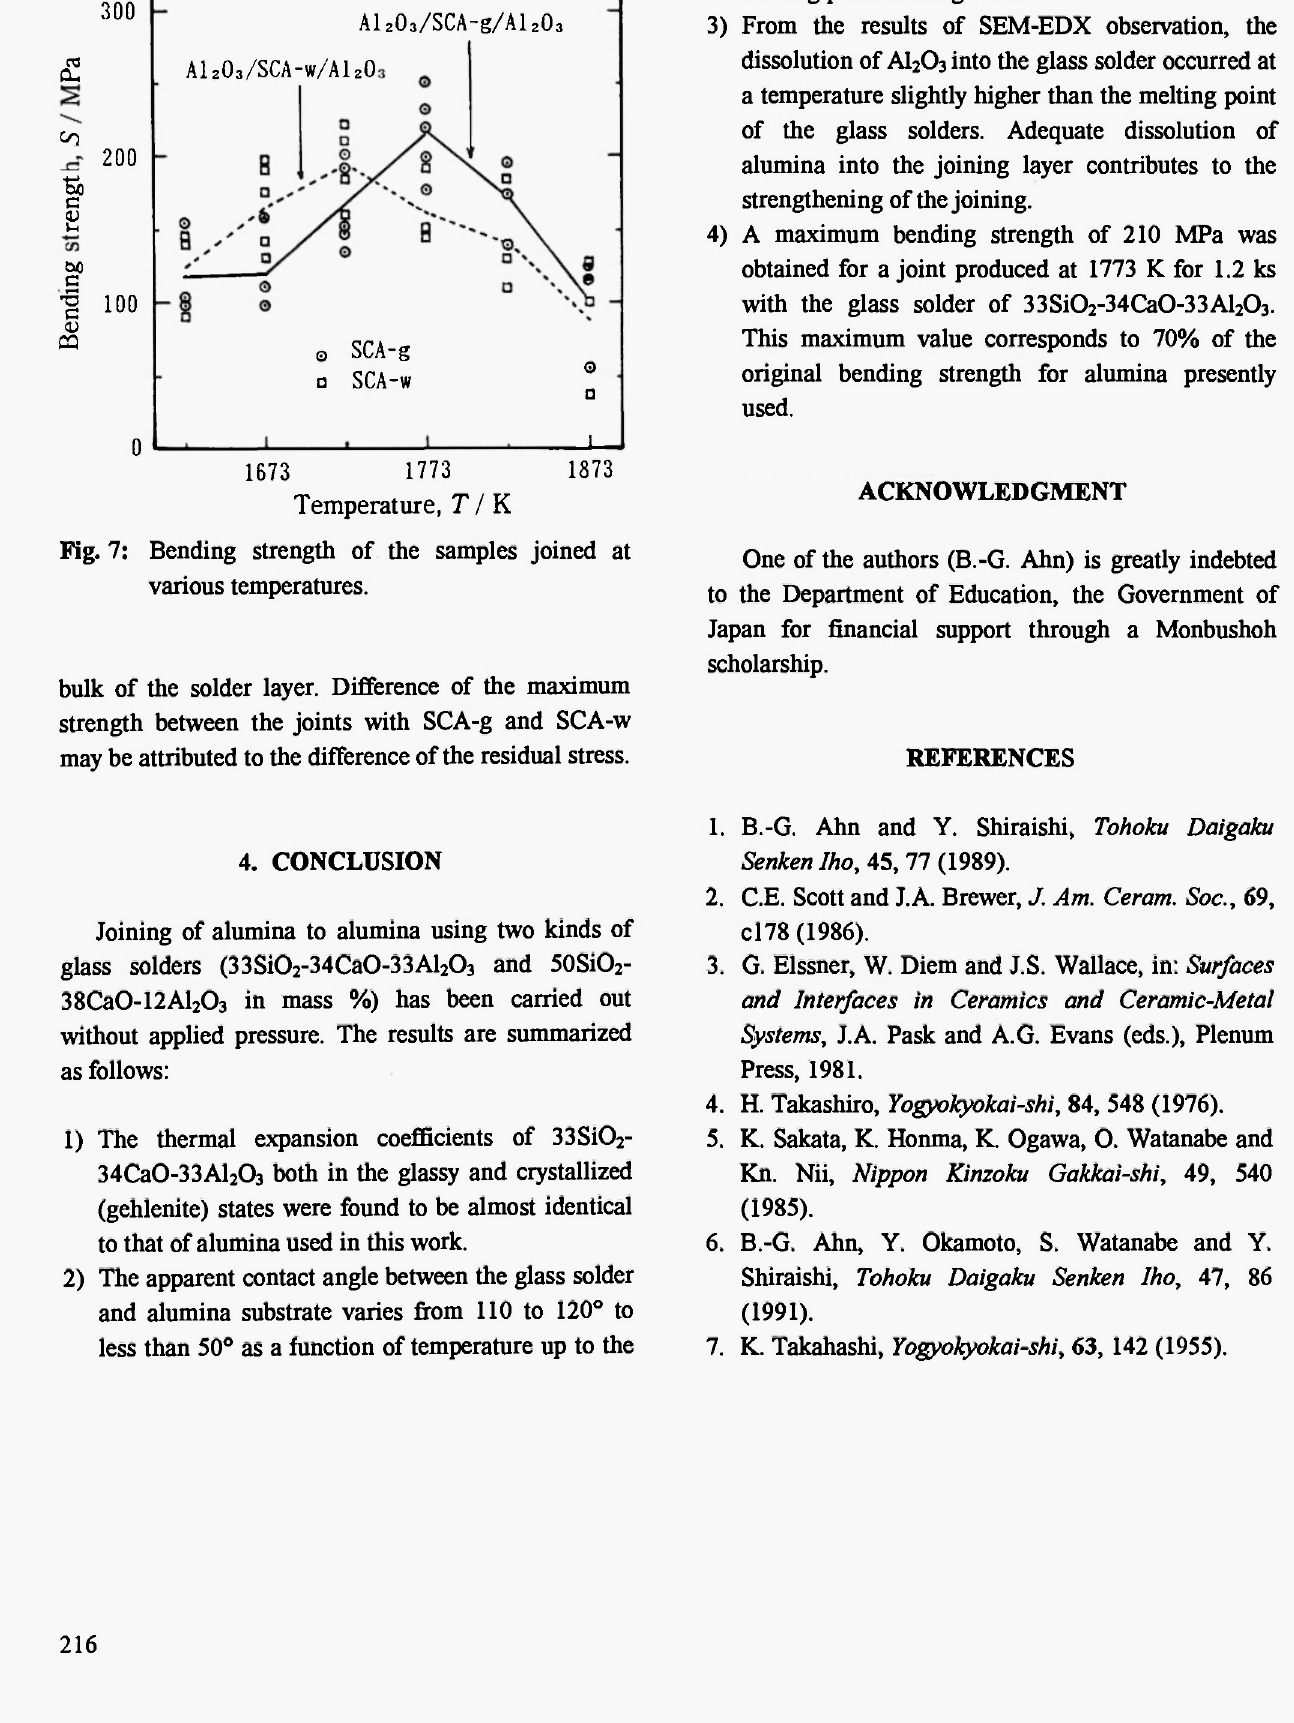
Fig. 7: Bending strength of the samples joined at various temperatures.